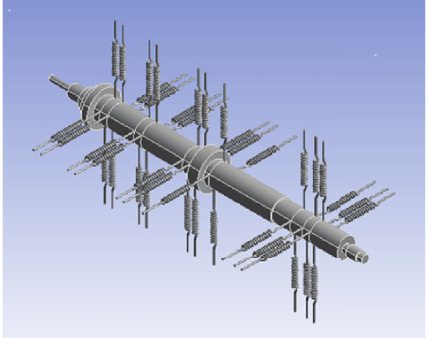
Figure 7: Spindle with bearings replaced with springs.